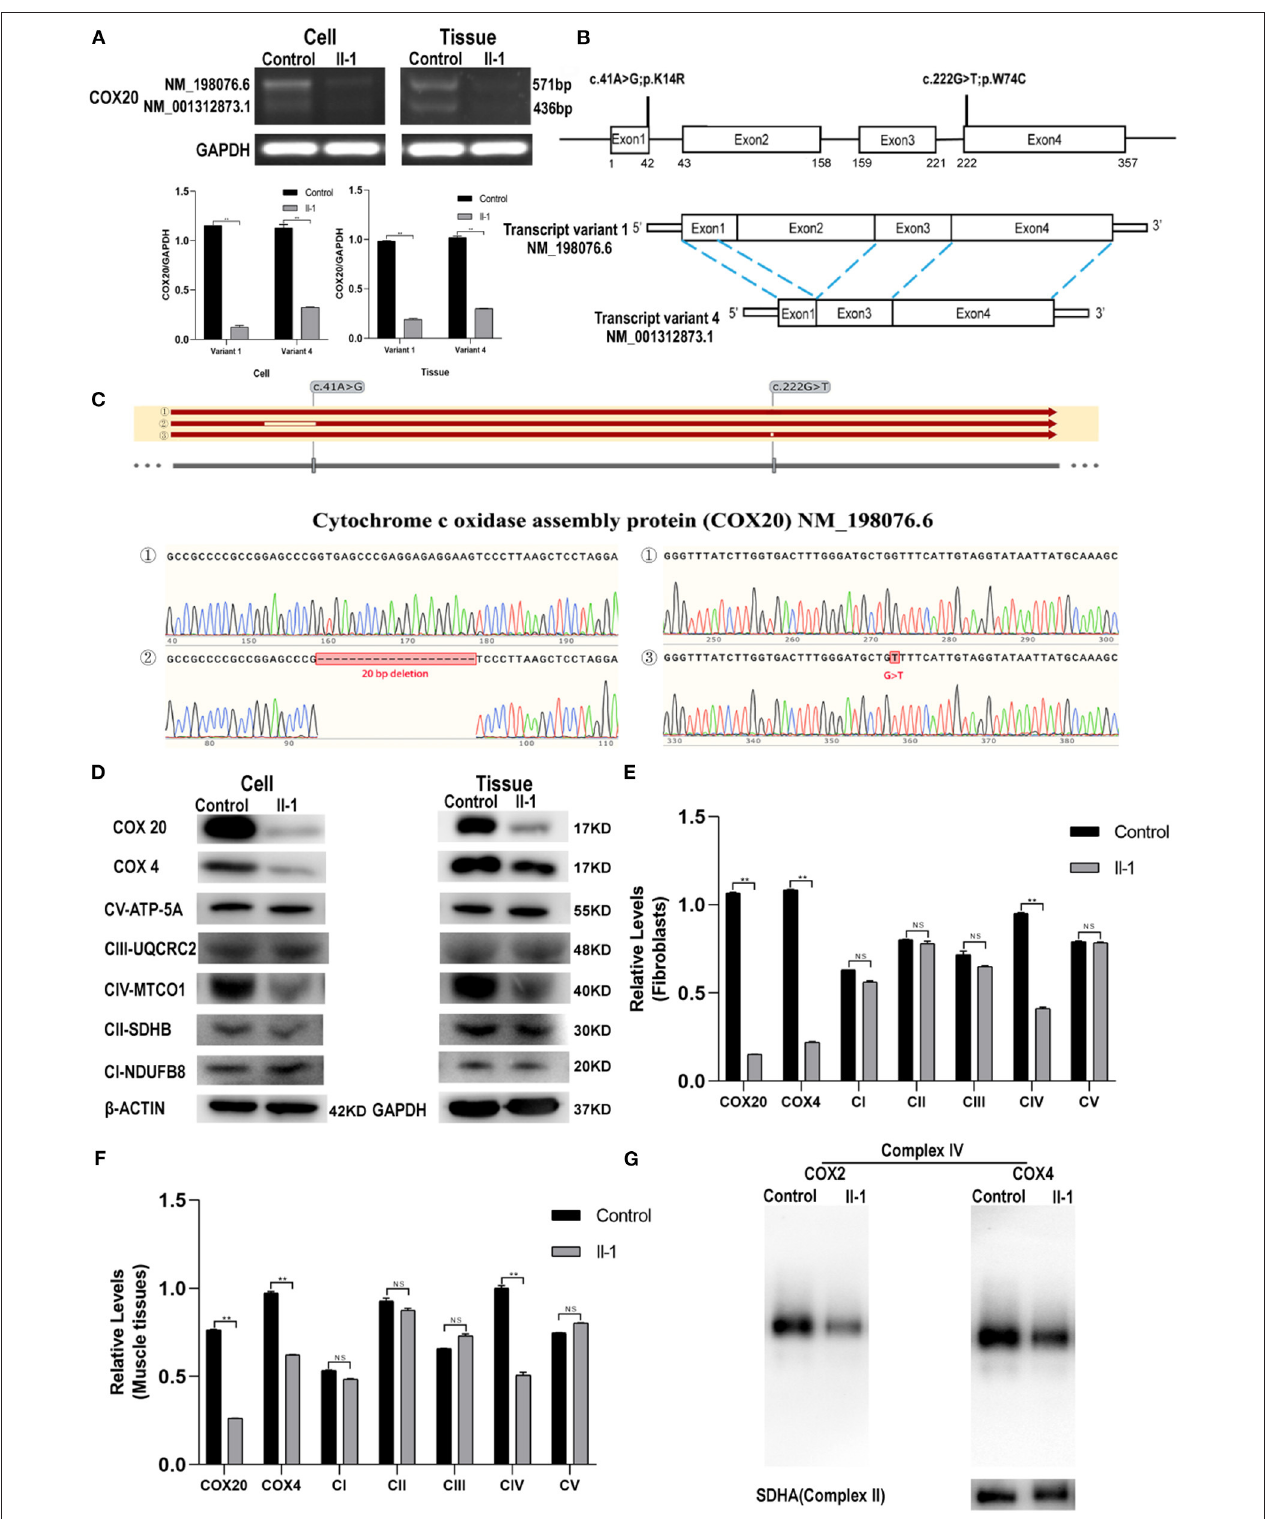
FIGURE 3 | COX20 mRNA and protein expression. (A) mRNA expression of COX20 in the muscle tissues and fibroblasts of the proband and control. GAPDH was used as the loading control. Significant differences in the mRNA levels exist between the groups. (B) Gene and cDNA schematic. c.41A > G and c.222G >